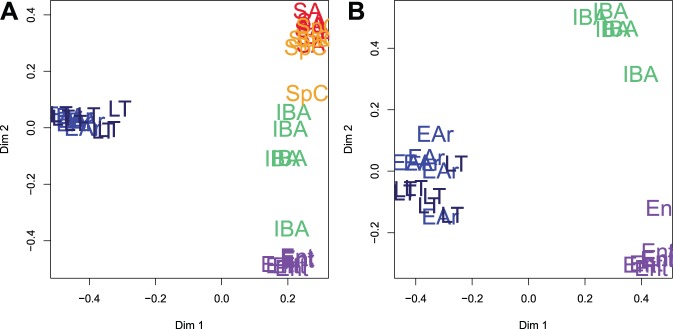
Sampled state separation by Random Forests. Data were clustered by Random Forests (50,000 trees) after variable selection to determine the minimum input protein spots required for the lowest classification error among groups. This was accomplished with (A) 22 protein spots for the base states and (B) 11 for winter states only (see Fig. 5).